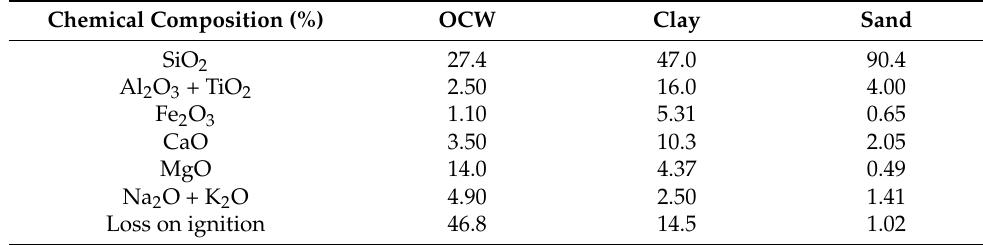
Table 2. Chemical compositions of OCW, clay, and